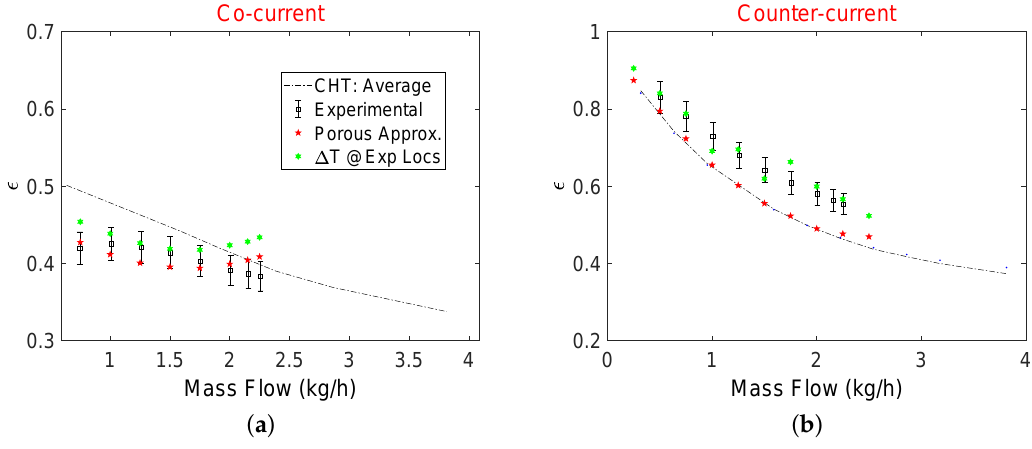
Figure 11. µ Hx effectiveness for cocurrent flow ( a ), and counterflow ( b